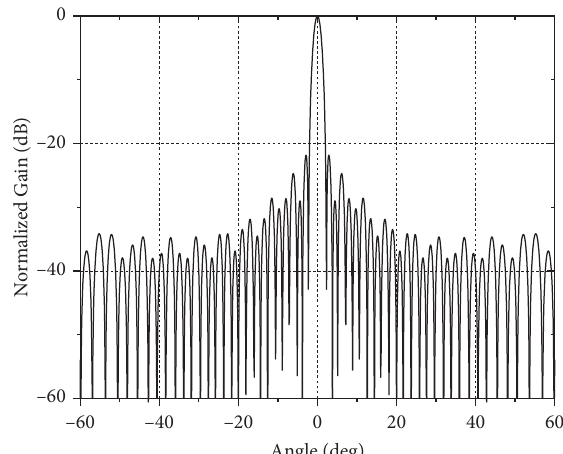
Figure 6: The calculated radiation pattern based on the optimi- zation results.